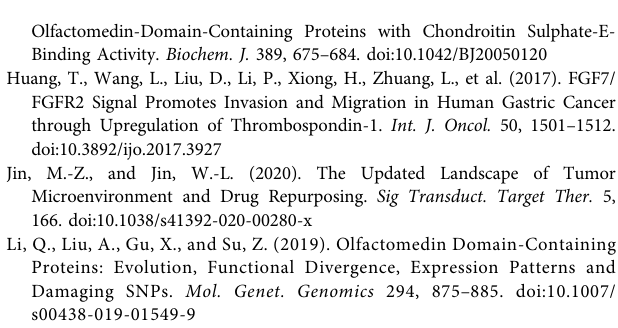
Supplementary Figure S1 | (A) Explanation of abbreviations. (B) Flow sheet diagram. Supplementary Figure S2 | Relative expression of OLFML2B in LIHC cell lines. Supplementary Figure S3 | Prognostic value of OLFML2B. (A) KM analysis of the association of OLFML2B and DSS. (B) KM analysis of the association of OLFML2B and DFI. (C) KM analysis of the association of OLFML2B and PFI. Supplementary Figure S4 | Results of GO analysis. Supplementary Figure S5 | Results of GO